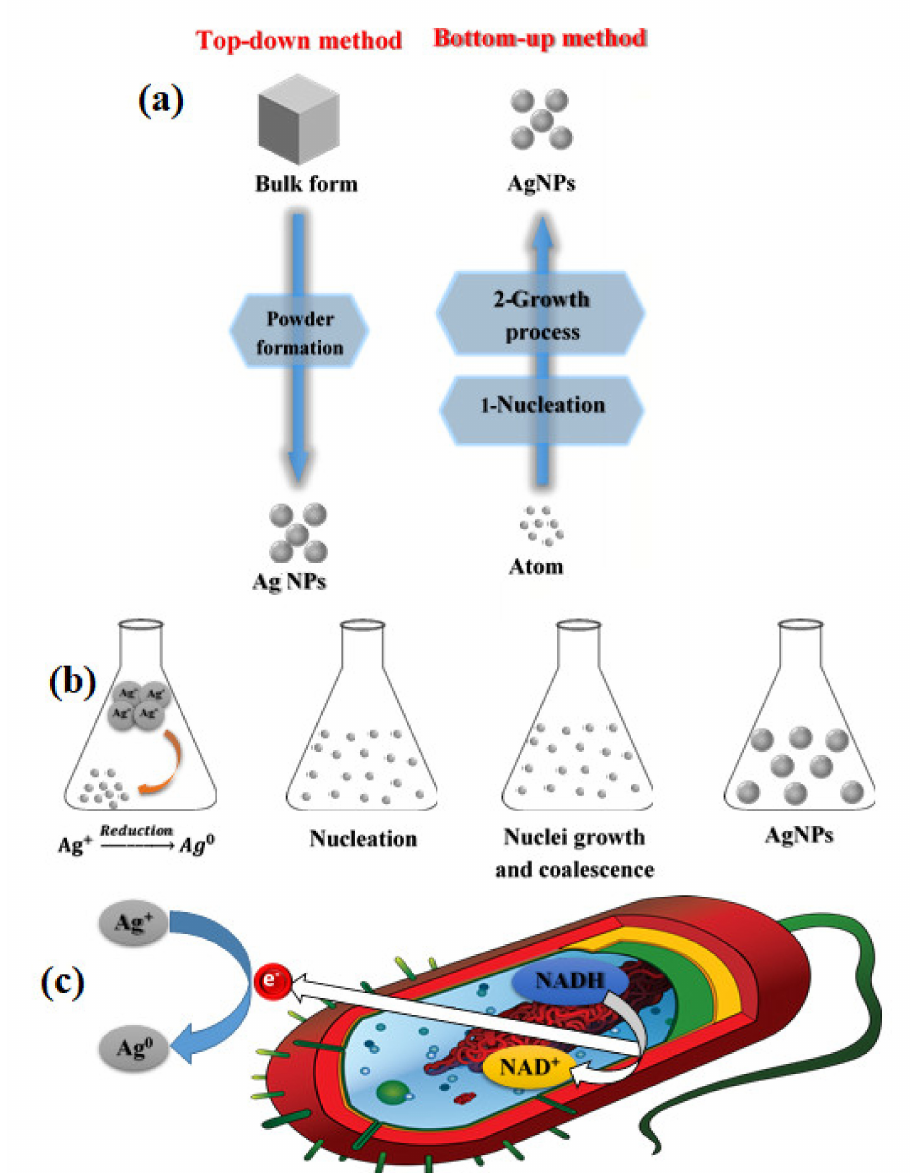
Figure 6. Synthesis routes of Ag NPs by ( a ) Top-down and bottom-up methods, ( b ) chemical methods, and ( c ) green methods, modified with permission from Ref. [55], MDPI, 2019. The electron transfer initiates the bioreduction through nicotinamide adenine dinucleotide (NADH)-dependent